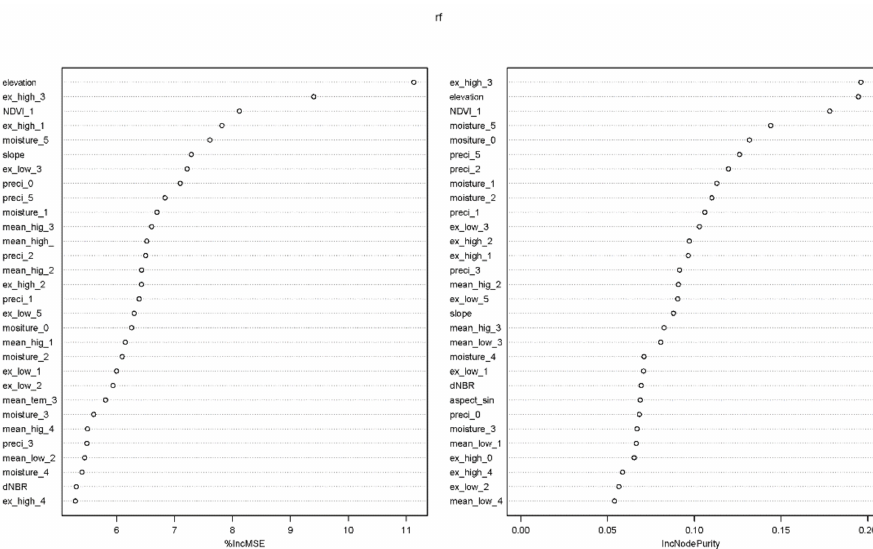
Figure 5. Variable importance ranking of all predictor variables. The acronyms of the predictive variable consist of two parts: abbreviation and number. Number means from the year after fire (the year of fire is 0) in the burned area. Abbreviation description: mean_tem (average annual temperature), ex_high (Extreme maximum temperature), ex_low (extreme minimum temperature), mean_high (average maximum temperature), mean_low (average lowest temperature), moisture (average relative humidity), preci (annual precipitation). A detailed description can be found in Table 2.). Table 5. The variables selection results of the stepwise multiple linear regression (SMLR).